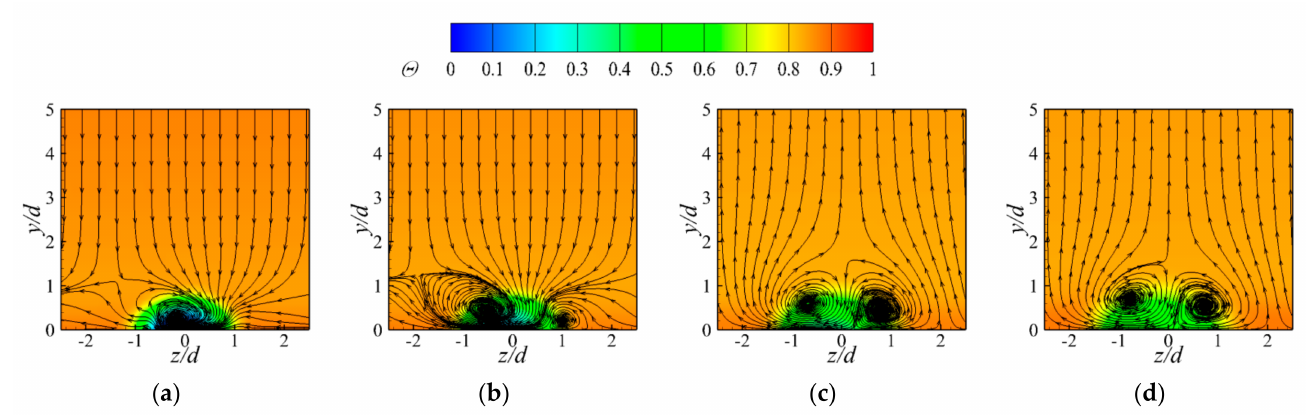
Figure 19. Dimensionless temperature contours and streamlines in downstream normal sections on the suction side for DJFC ( Z / d = 0 and β = 29 ◦ ) under M = 1.5. ( a ) s / d = 3, ( b ) s / d = 6, ( c ) s / d = 12, ( d ) s / d =